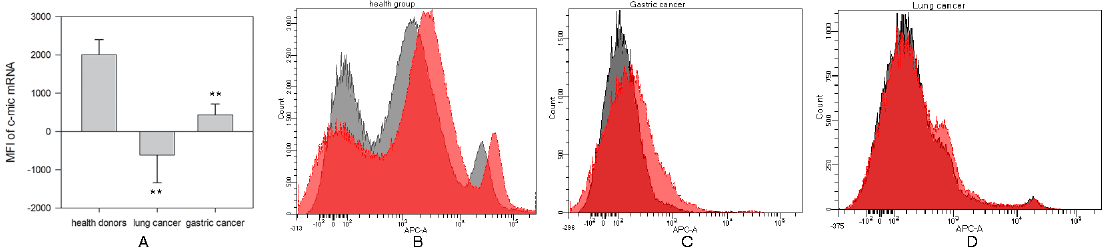
Figure 1. Differences in c-myc mRNA expression in NK cells harvested from healthy donors and cancer patients. NK cells were isolated from the peripheral blood samples by negative selection using Dynabeads, incubated in complete medium for 20 h and c-myc expression was determined by Smart Flare method as described in M&M. ( A ) Data of mean fluorescent intensity (MFI) are shown as the mean ± SEM (ANOVA). ( B ) C-myc-mRNA expression in peripheral NK cells from one of 10 representative healthy donors. ( C ) C-myc-mRNA expression in peripheral NK cells from one of 7 representative patients with lung cancer. ( D ) C-myc-mRNA expression in peripheral NK cells from one of 12 representative patients with gastric cancer. ( B – D ) The relative expression was determined by flow cytometry on stained NK cells.